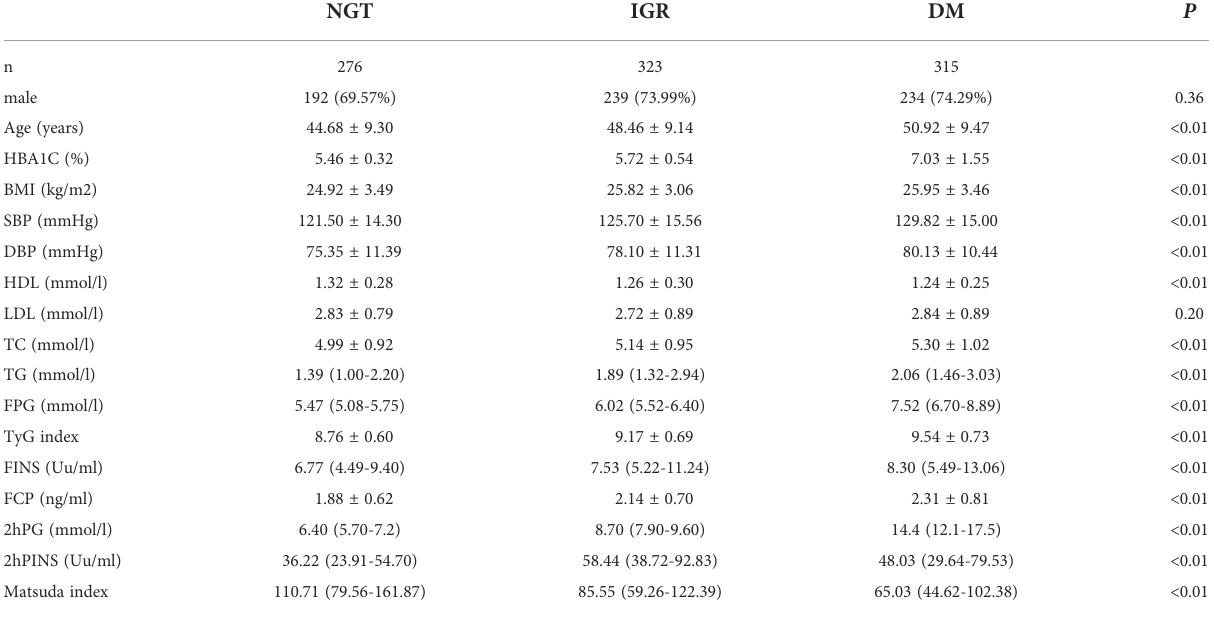
TABLE 1 Clinical characteristics of research